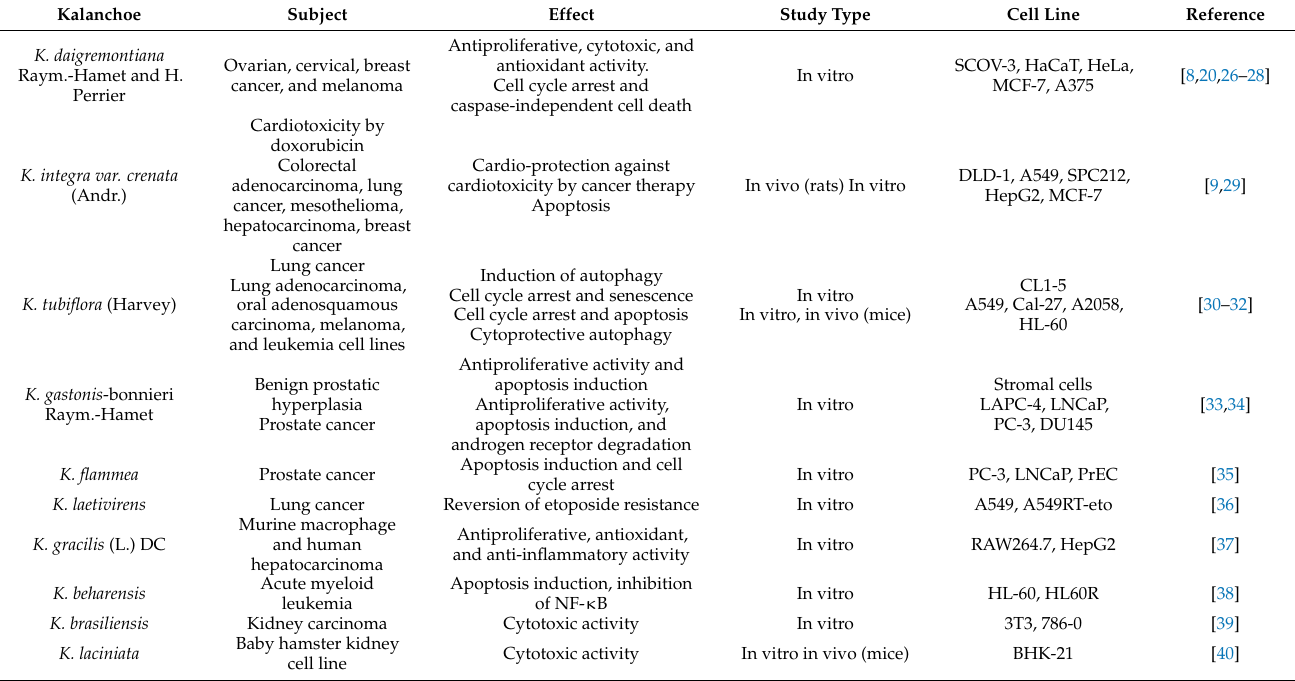
Table 1. Anticancer properties found in the Kalanchoe